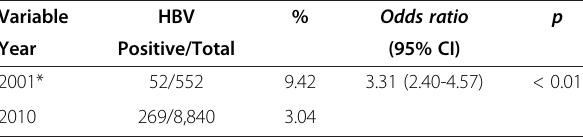
Table 2 Difference in the prevalence of hepatitis B